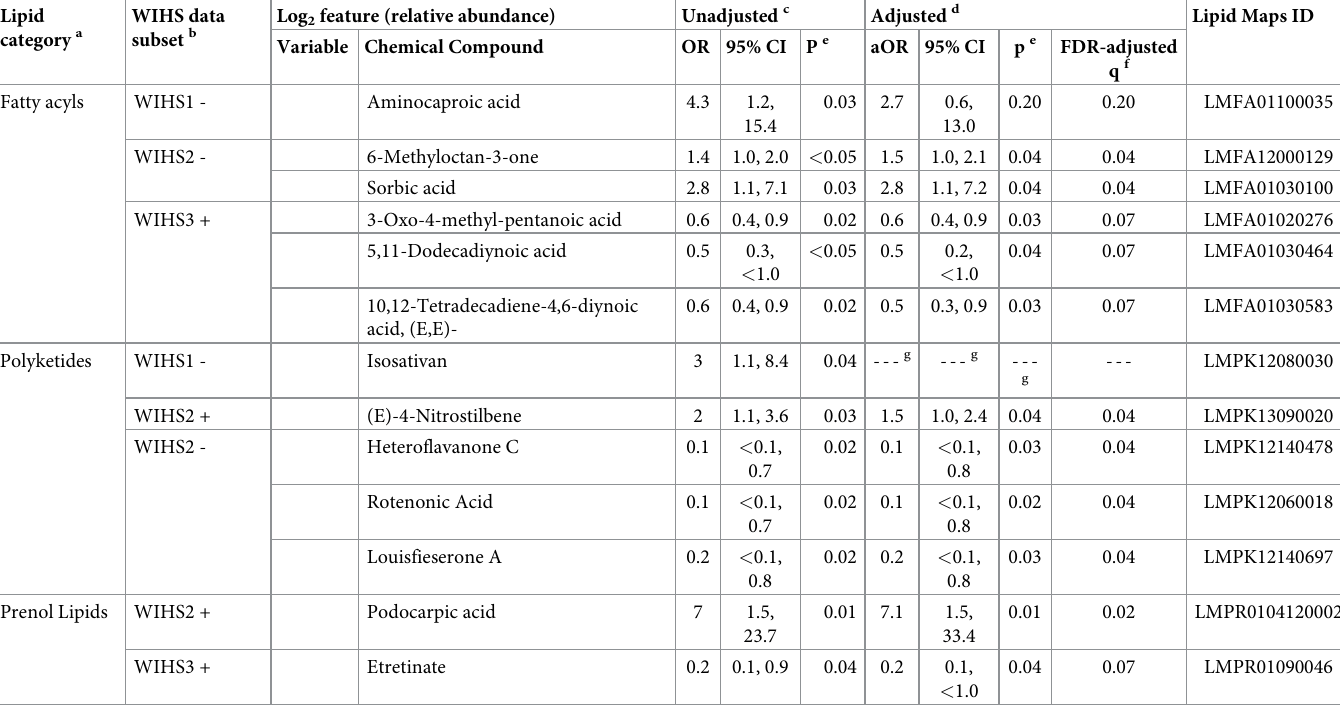
Table 3. Associations between selected features and study groups (DM cases versus controls). WIHS data Lipid subset category a